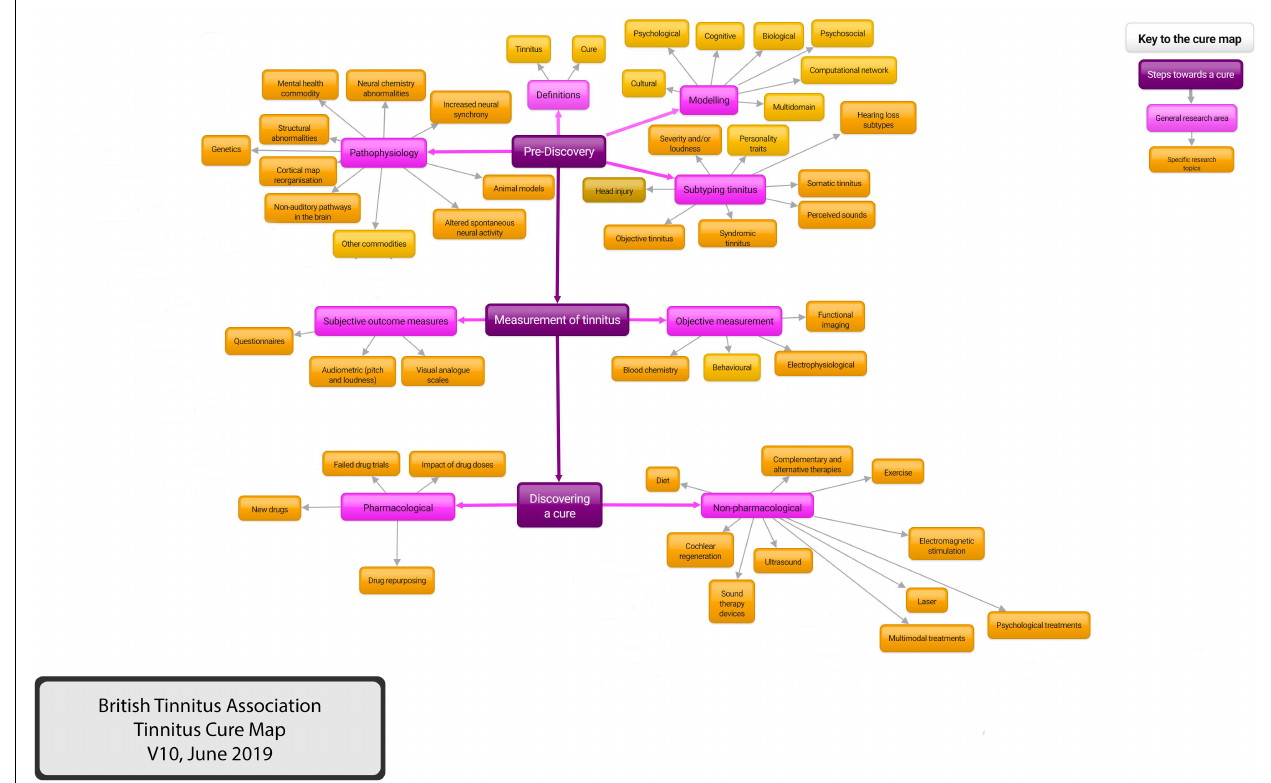
FIGURE 4 | The British Tinnitus Association Tinnitus Cure Map. A representation of tinnitus research areas. An interactive version accessed via the internet is being developed, demonstrating knowledge gaps but also demonstrating areas where we already know the answer and blind alleys that do not need further exploration. The interactive version will connect to other internet resources via hyperlinks. For purposes of clarity, this version of the Cure Map has been limited to three levels. A more comprehensive version with four levels is included in Supplementary Material